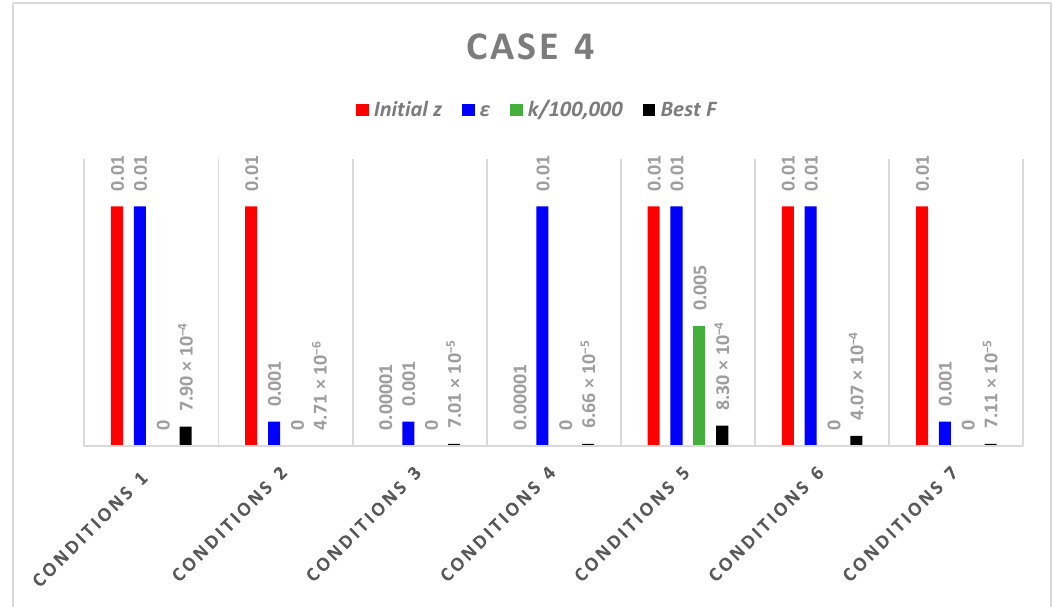
Figure 8. Graphical presentation of Table 7.